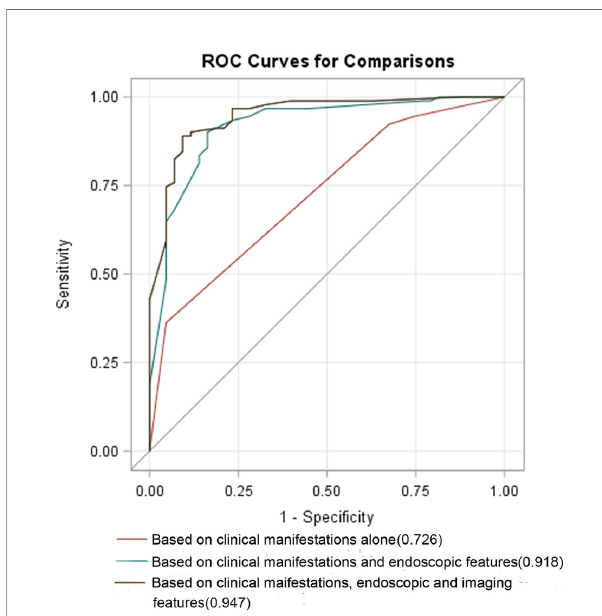
FIGURE 3 | ROC curves based on different variables. The AUC for differentiating CD and UPIL based on clinical manifestations alone, combined clinical manifestations and endoscopic features, combined clinical manifestations, endoscopic, and imaging features was 0.726, 0.918, and 0.947, respectively.